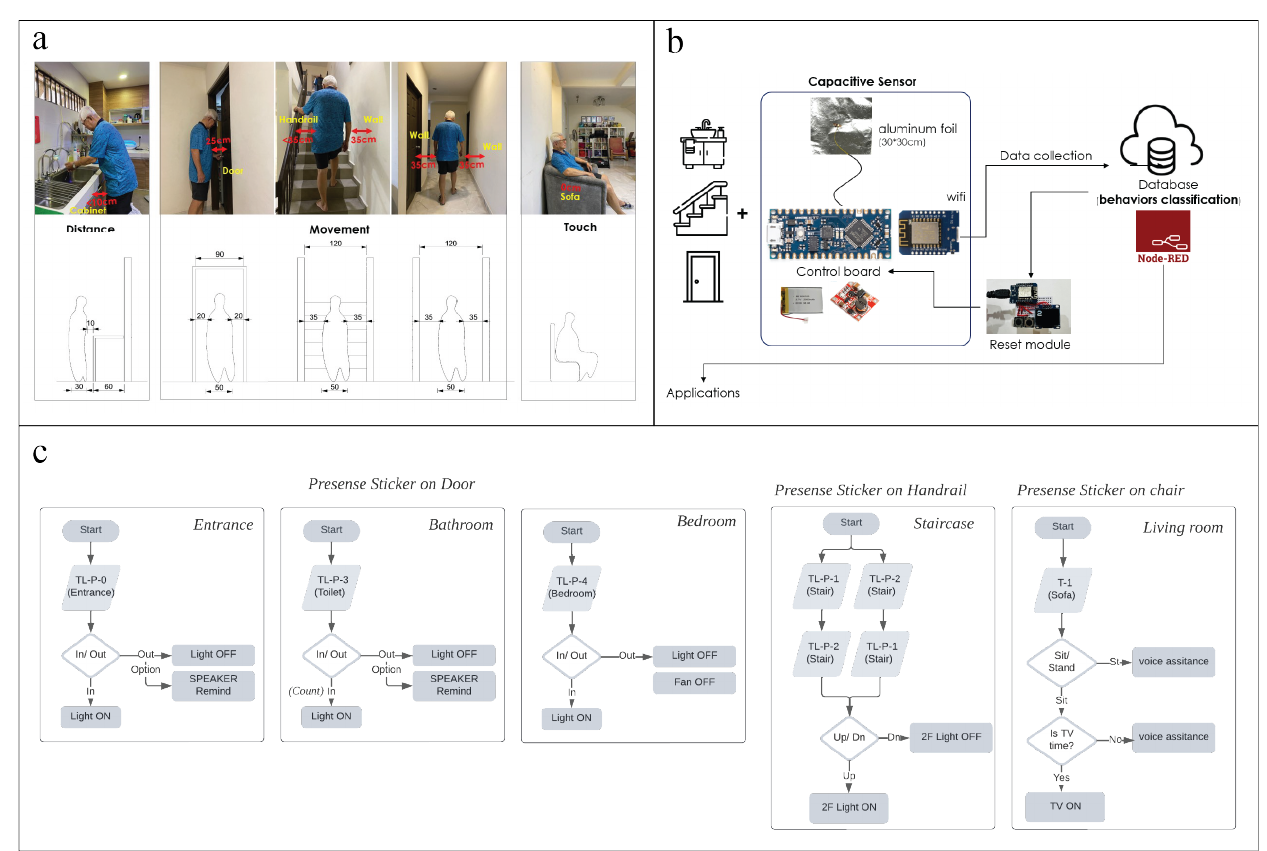
Figure 4. ( a ) (Top Left). The behaviors of the elderly subject in three dimensions. ( b ) (Top Right). The information framework of the Presence Stickers. ( c ) (Bottom). Application: flow charts of smart life assistance.